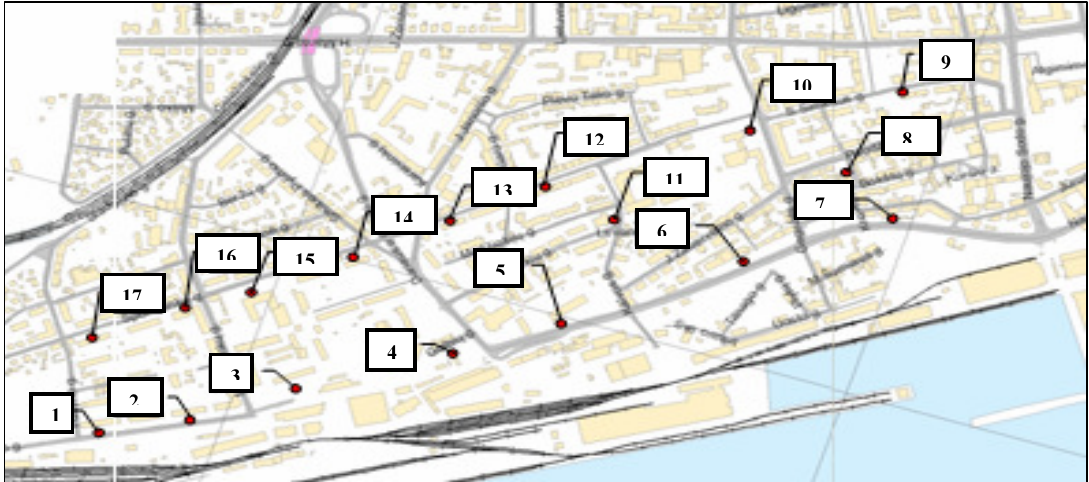
Fig. 1. Measurement points of noise level in Klaipėda city